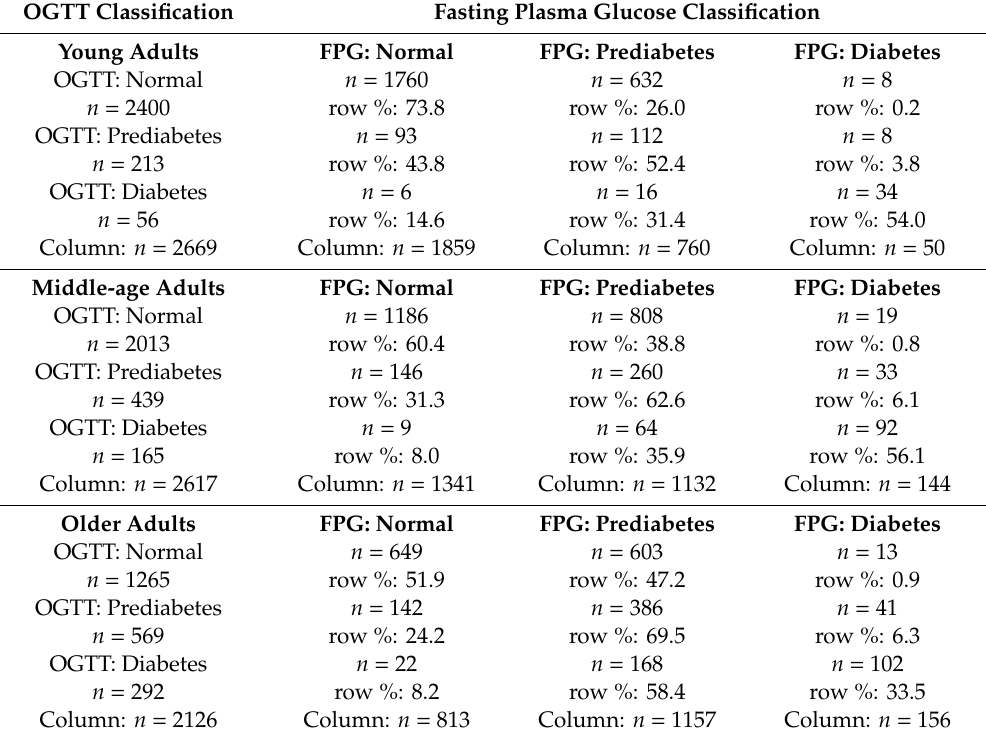
Table 5. Agreement between test results for the OGTT and FPG in U.S. adults analyzed by age group,